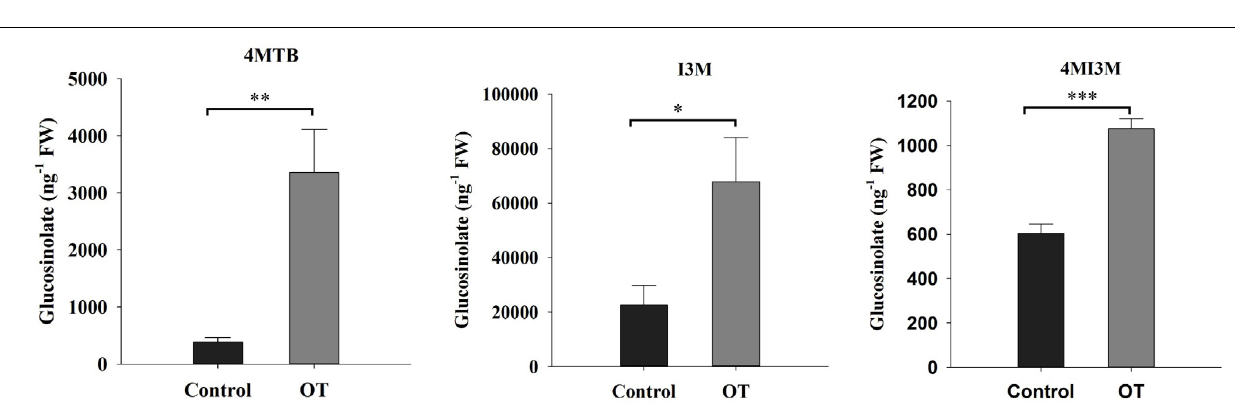
1-methoxyindol-3-ylmethyl glucosinolate in cauliflower